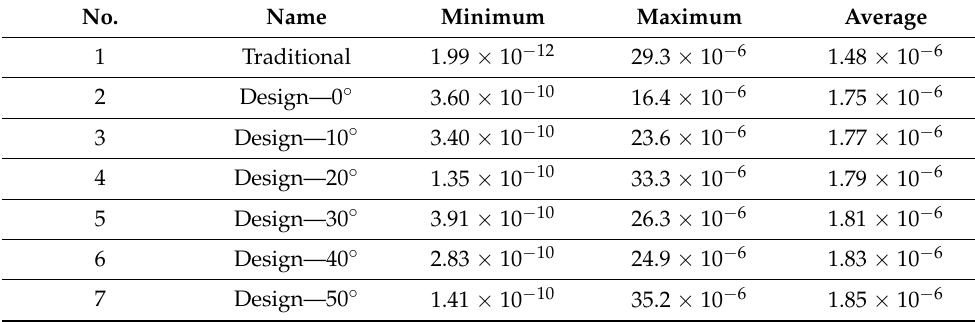
Table 4. First principal strain (1) of each plate.